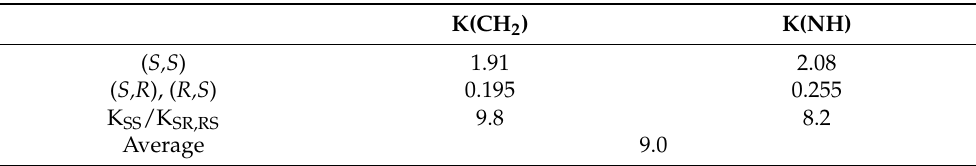
Table 1. Observed CIDNP enhancement coefficients (K) of protons and its ratios K SS /K SR, RS for KP-Trp dyad in